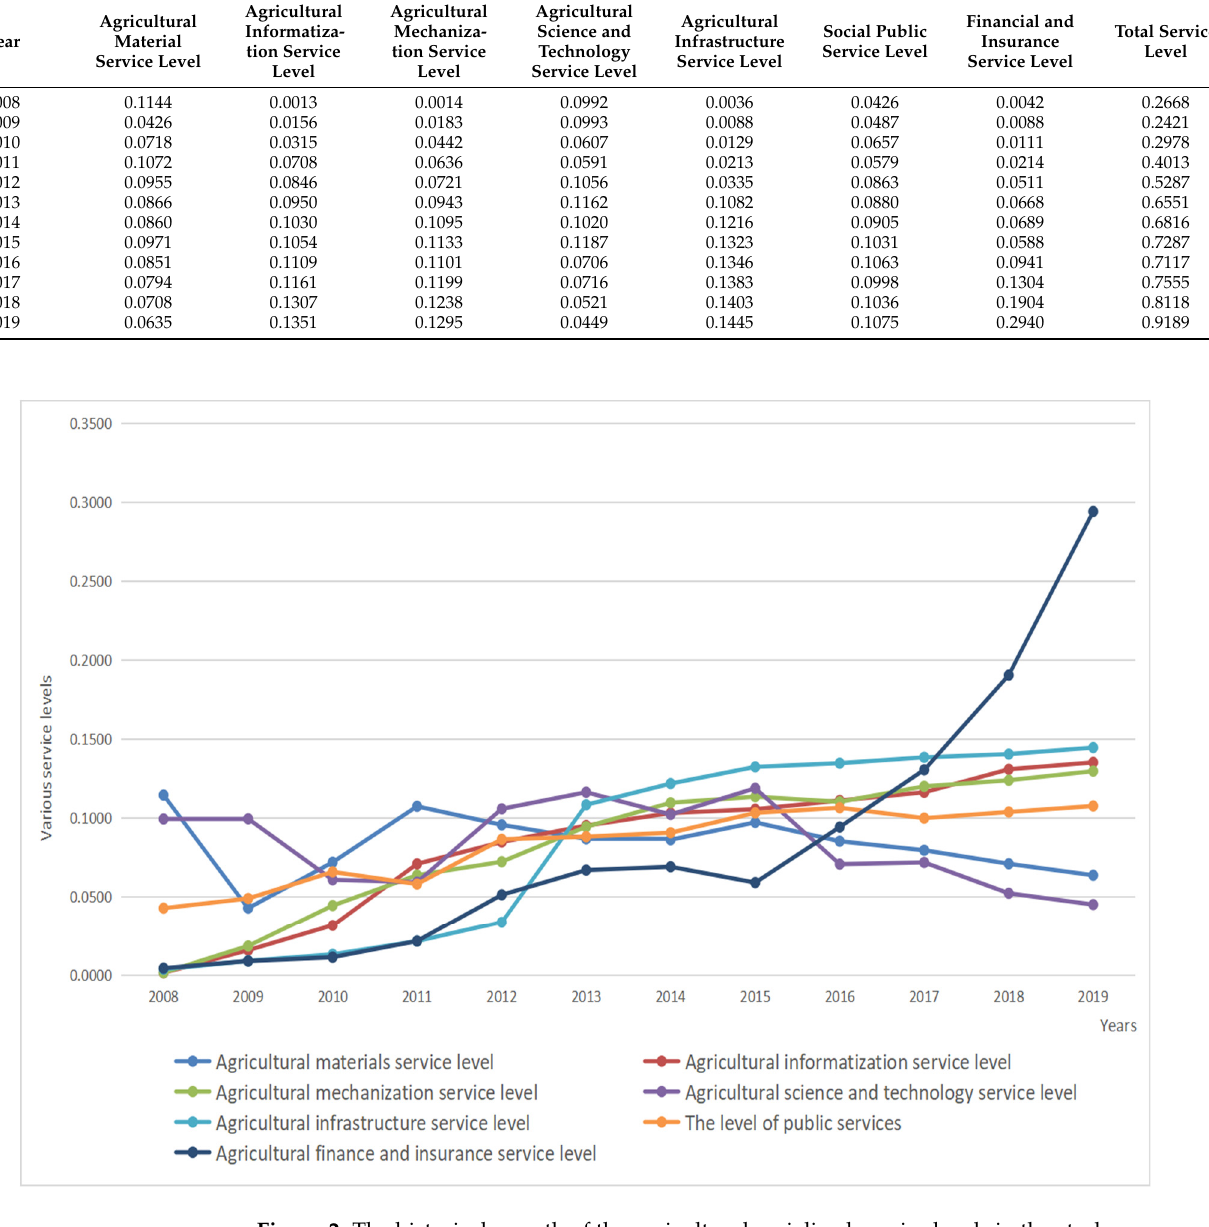
Figure 2. The historical growth of the agricultural socialized service levels in the study area.